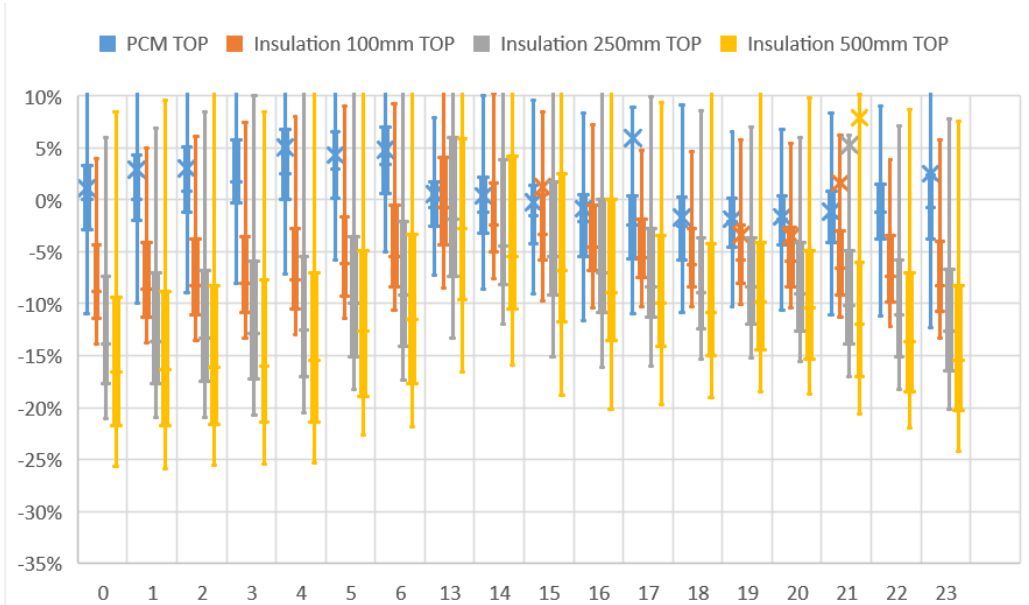
Figure A2. Annual percentage difference distribution of cooling load vs. hours of days on typical floor. Note: The unit for the x-axis is %diff, the unit for the y-axis is hour.